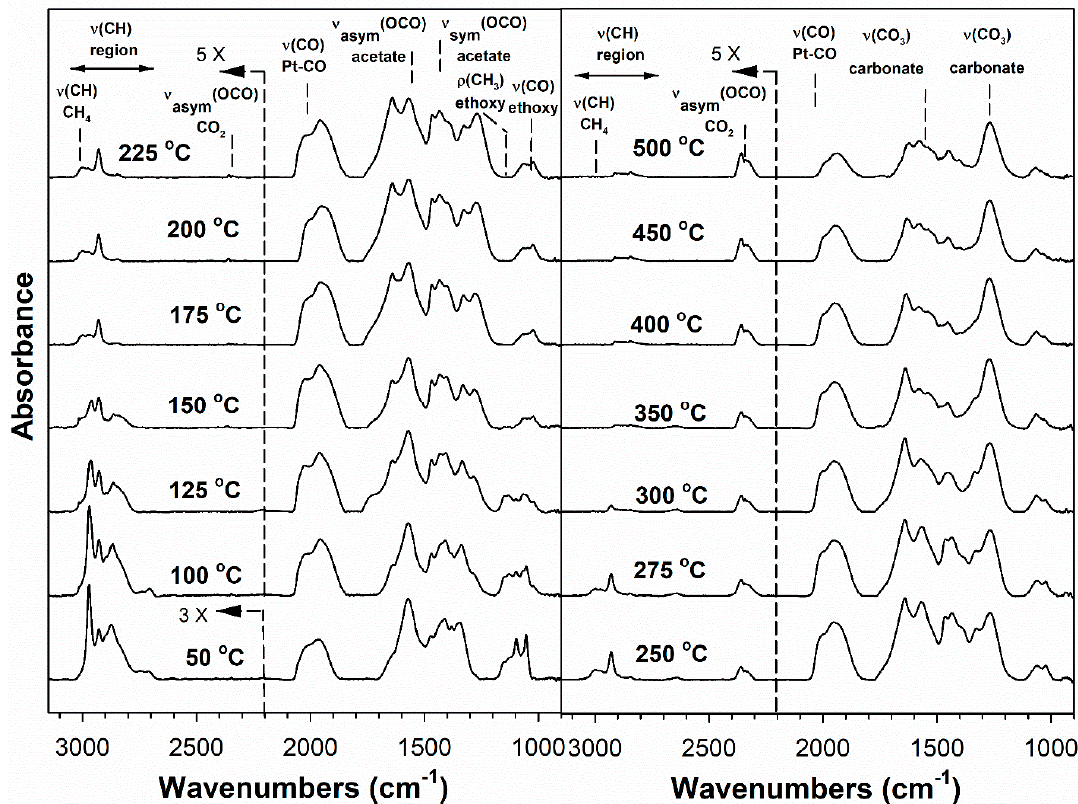
Figure 6. DRIFTS of transient ethanol steam reforming over 3.9% Cs-2% Pt/ZrO 2 .